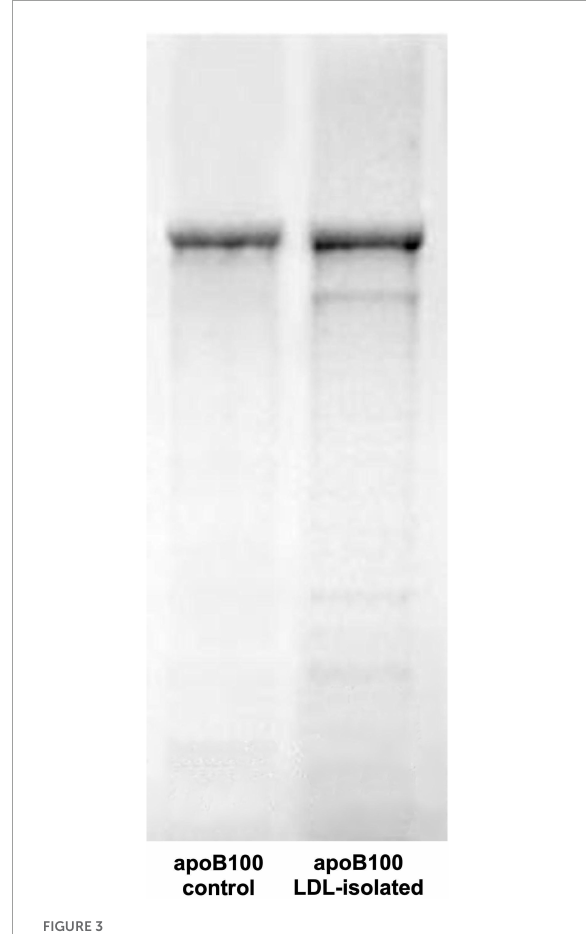
FIGURE3 SDS-PAGE electrophoresis of human LDL apoB100. The gel shows apoB100 isolated from LDL (sample band in right gel column) against pure apoB100 (control band in left gel